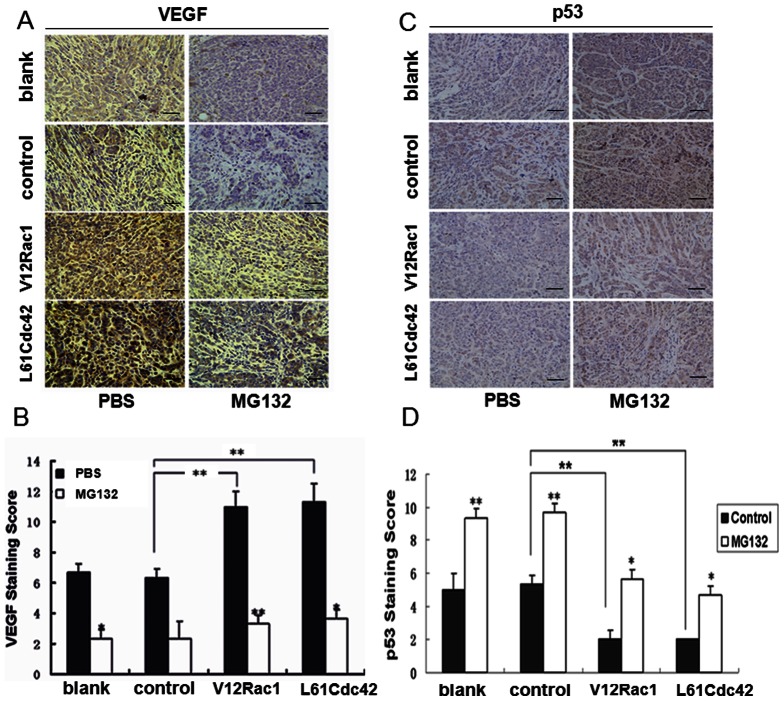
Effect of intratumoral injections of MG132 on vascularization induced by active Rac1/Cdc42 in MCF-7 cell xenografts.These experiments were described in the Materials and Methods section. Stably transfected cells (MCF-7, GST–MCF-7, V12Rac1–MCF-7, L61Cdc42–MCF-7) were used for xenografts in nude mice. When the tumors reached a volume of 200 mm3, the mice were treated with intratumoral injections of a specific dose of MG132 (10 mg/kg) or PBS. (A, B) Intratumoral vascularization was assessed by VEGF and p53 immunolabeling (400 × power) on paraffin-embedded MCF-7 cell tumor sections. Representative images are shown. Integrated optical density (IOD) values of VEGF and p53 protein expression were evaluated. ImagePro Plus software was used to analyze the IOD values of the positive areas of immunohistochemical staining. The resulting histograms are presented here. A statistical analysis was performed using a one-way ANOVA. The results are presented as mean ± SD for six mice. *P<0.05; **P<0.01.